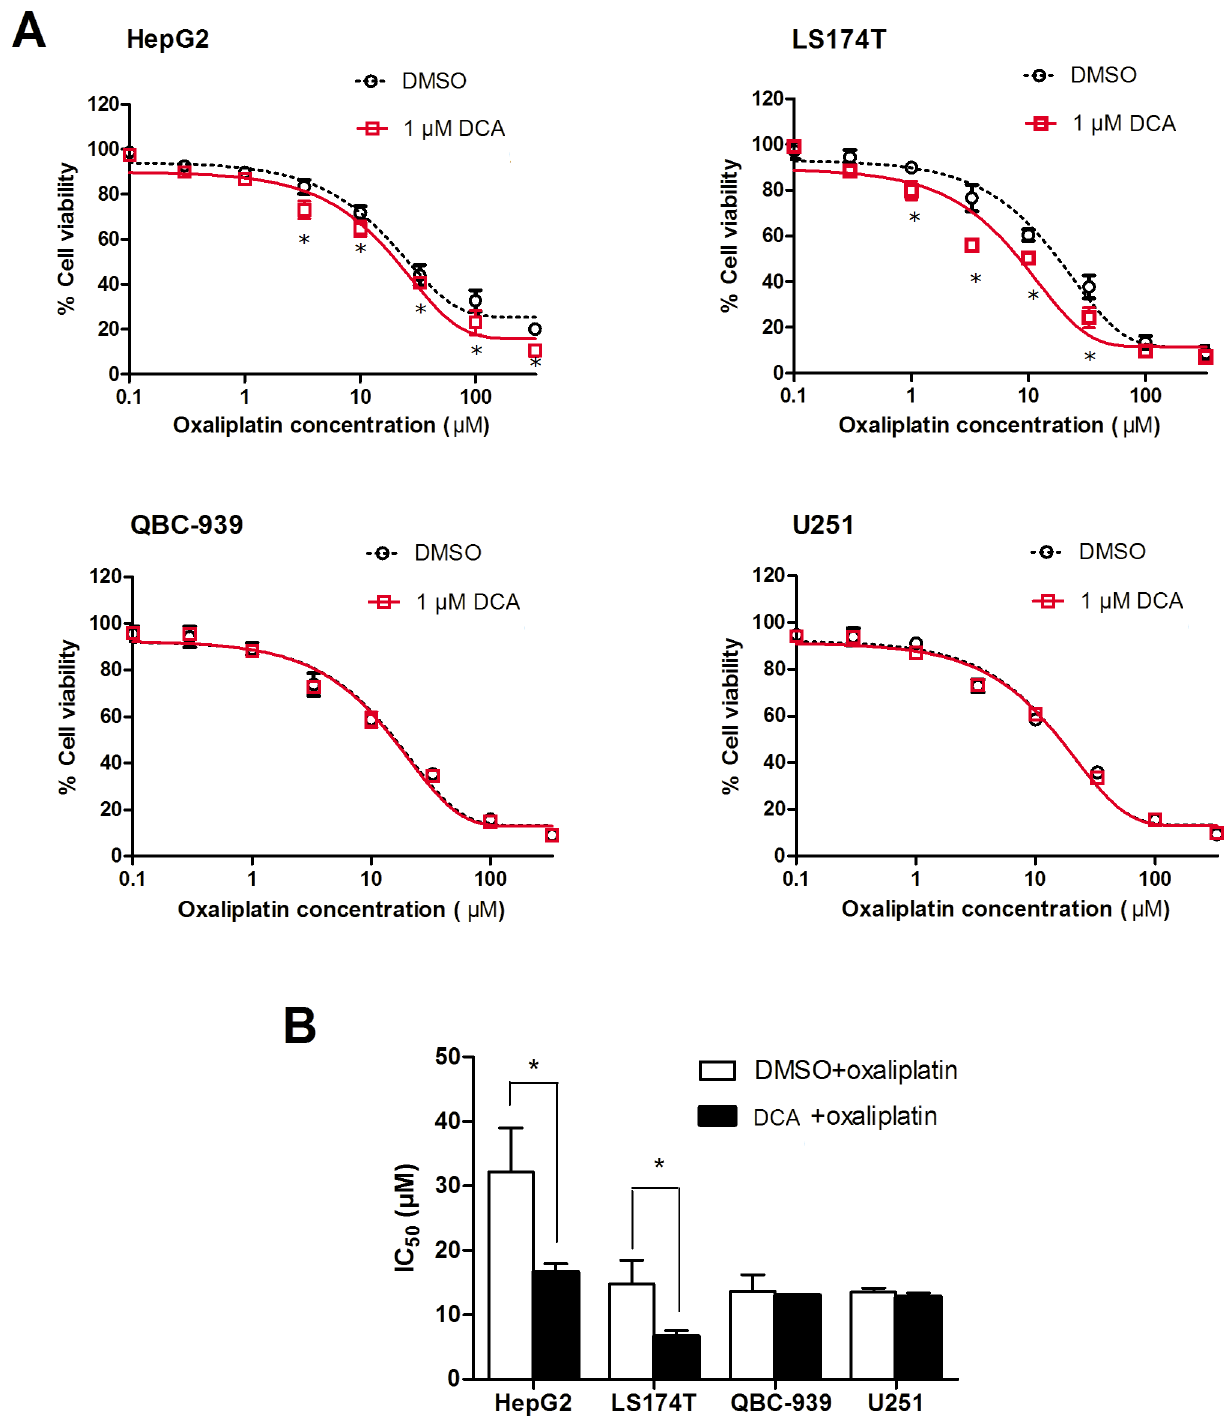
Figure 7. Demethylation of OCTN2 by DCA influenced cell viability to oxaliplatin. Cancer cells were pre-treated with 1 m M DCA for 1 week, seeded in 96-well plates at 1 6 10 4 cells/well in 100 m l DMEM and 10% FBS. After 8 h, the cells were exposed to oxaliplatin at various concentrations (0.1, 0.3, 1.0, 3.3, 10, 33, 100 or 330 m M) for 48 h in fresh culture medium. Cell viability was determined by a MTS cell proliferating assay kit. Each concentration was determined in three wells. Data presented represent the mean 6 S.D. of three independent experiments. (A), the cell viability at each concentration was displayed. Significant differences from DMSO treatment are denoted with an asterisk (*, p , 0.05). (B), IC 50 values were calculated by SPSS 13.0 software. Data presented represent the mean 6 S.D. of three independent experiments. Significant differences from non- treated cells are denoted with an asterisk (*, p , 0.05).